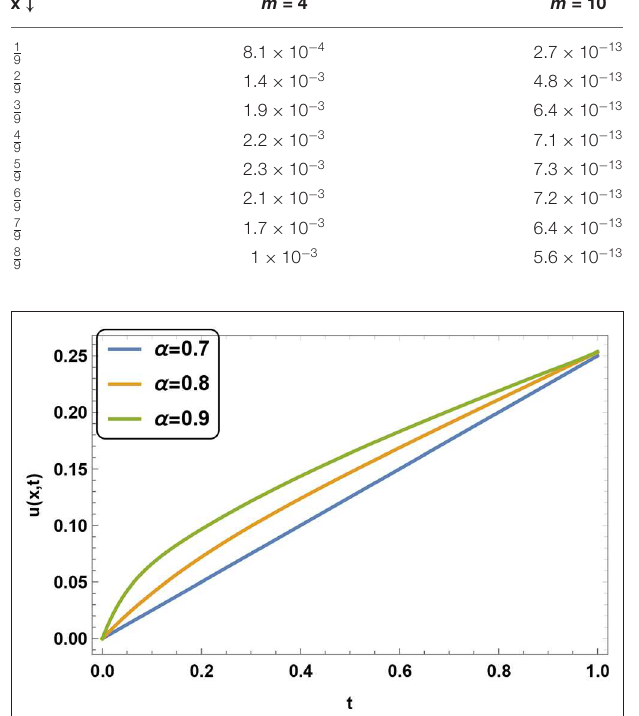
FIGURE 2 | Plots of u at space position x = 0.1 for m = 4 at different value of α .